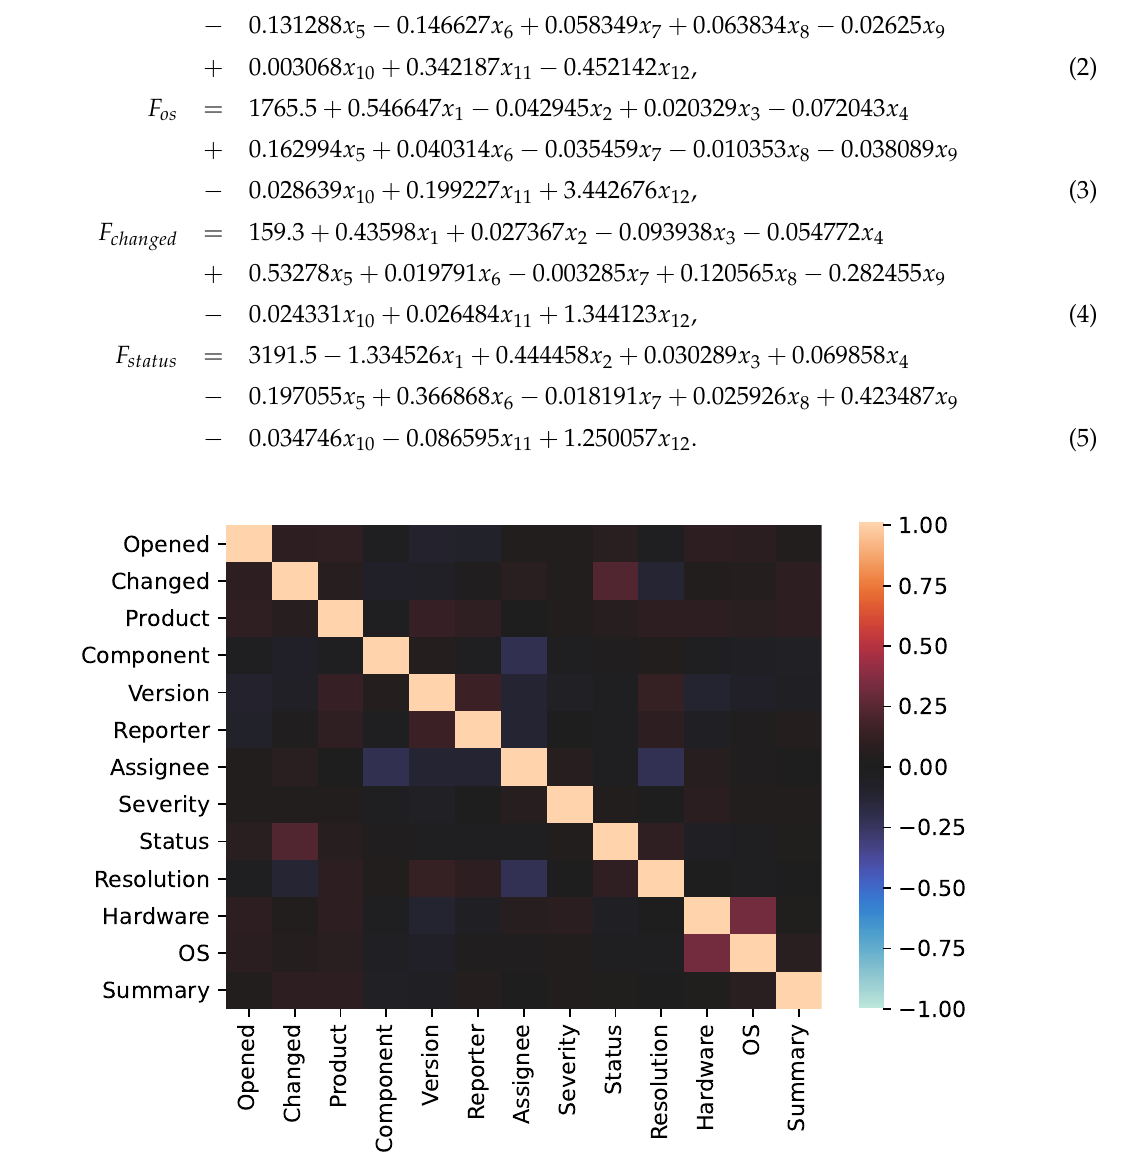
Figure 5. The heatmap for actual fault big